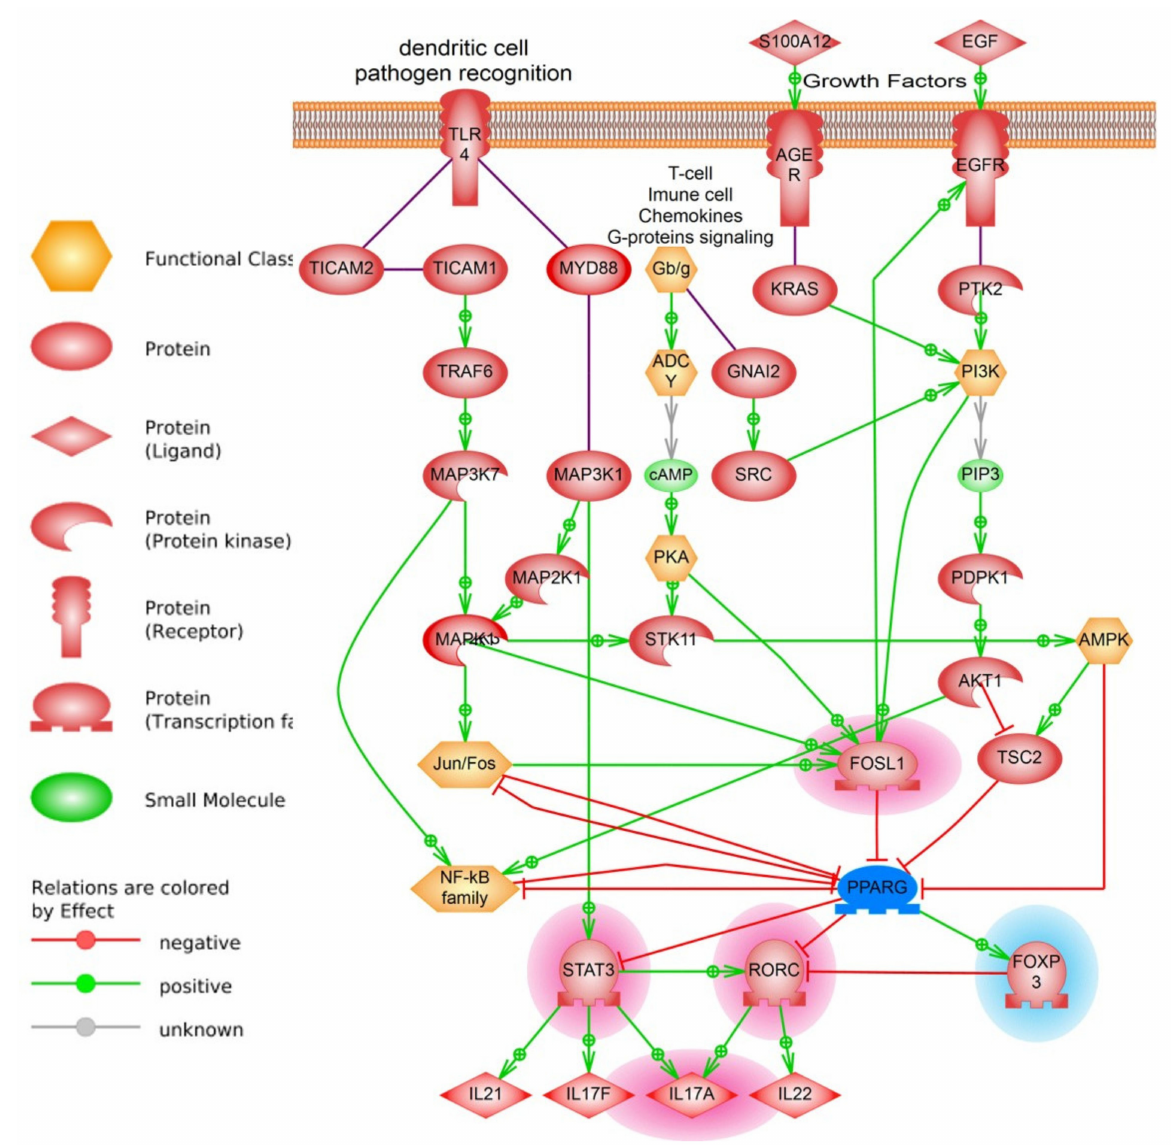
Figure 7. Model of PPAR γ pathway in psoriasis (simplified version). Changes in gene expression are highlighted according to results of analysis in red (over-expressed genes) and in blue (down-expressed genes). In psoriatic lesion, cytokines, growth factors, pathogens, apoptotic debris as well as dendritic cells activates TLRs, AGER and EGFR among other receptors on the surface of keratinocytes and T-cells. Activates receptors transfer the signal to their canonical cascades such as G-couple proteins, PI3K, PKA, MAPK1, or calcium (not shown). As a result, several direct inhibitors of PPARG protein such as TSC2 or inhibitors of PPARG expression ( FOSL1 , Jun/Fos) became over activated. When PPARG is inhibited on both RNA expression and protein levels, this causes higher than normal expression of interleukins (such as IL17A ) via STAT3 and RORC transcription factors. See supplemental materials for references and links to publications that support protein-protein interactions in the